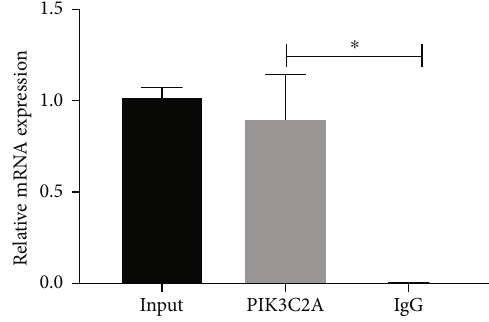
Figure 12: The interaction between C/EBP α and PIK3C2A was identi fi ed using the ChIP assay. ∗ P < 0 : 05 vs.